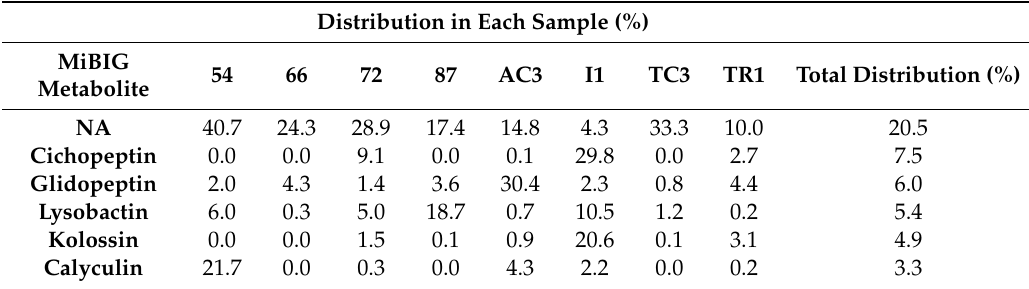
Table 3. Distribution of the five most abundant MiBIG metabolites assigned to the AD domain sequences. The distribution (in relative abundance) of each metabolite by sample as well as the total distribution of the metabolite across all the samples is